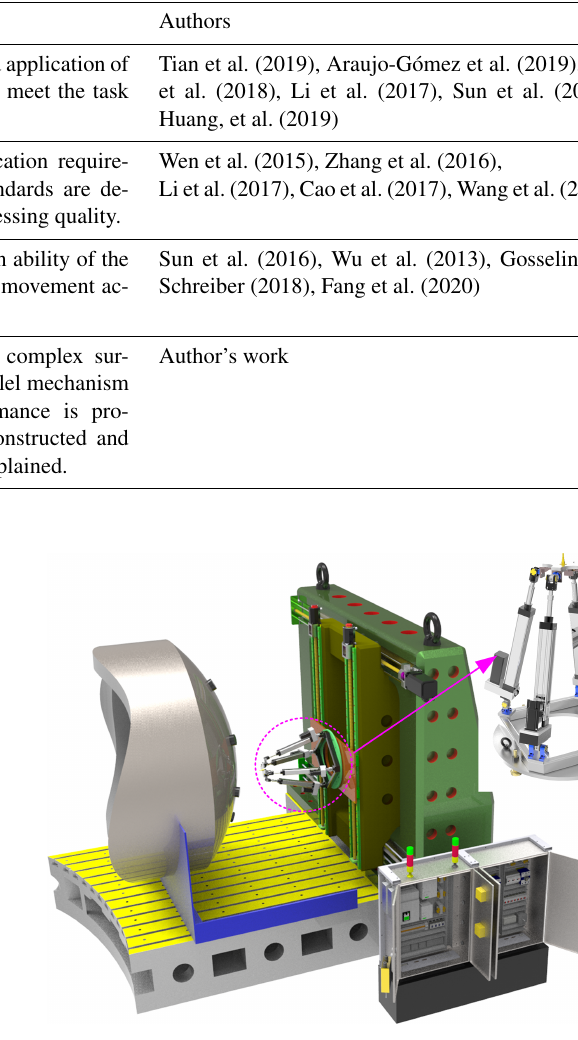
Figure 1. Five-axis linkage processing